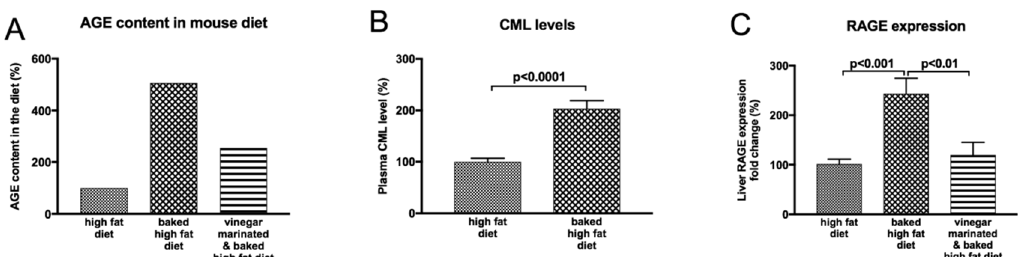
Figure 6. Relationship between dietary AGEs, circulating AGEs and RAGE expression. Baking high fat diet at 160 °C for 1 hour dramatically increases AGE content in the diet ( A ), leading to increased circulating AGE (CML) levels ( B ). Moreover, high dietary AGE intake exacerbates liver RAGE expression ( C ). Marination of high-fat diet prior to baking has beneficial effects as reflected by reduced formation of AGEs in the diet ( A ), leading to a reduced liver RAGE expression ( C ). AGE: advanced glycation end products, RAGE: receptor for advanced glycation end products, CML: N ε - (carboxymethyl)lysine.